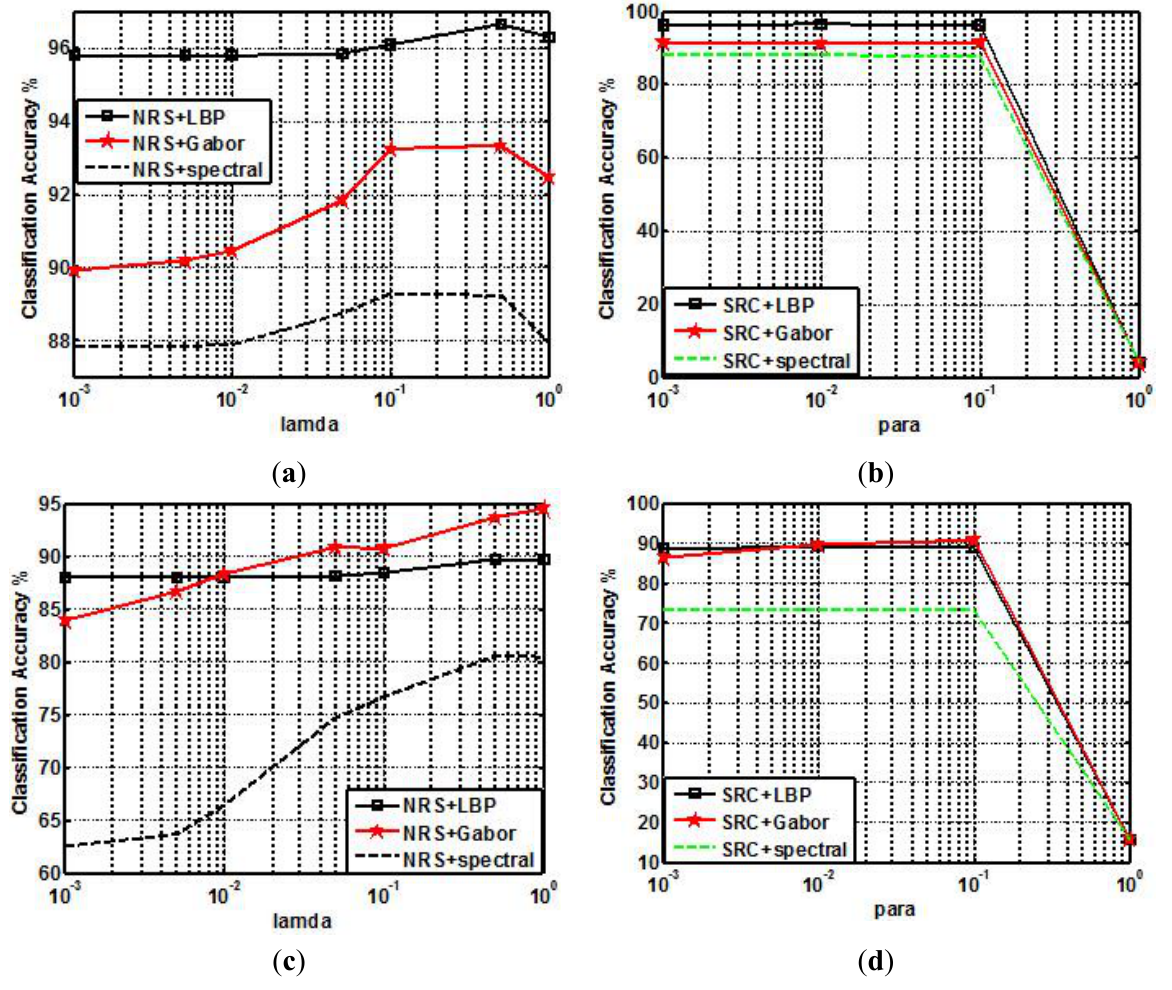
Figure 6. Classification accuracy (%) on two datasets using different parameters for  : ( a ) and ( b ) Salinas dataset with 30 training samples per class, and ( c ) and ( d ) University of Pavia dataset with 60 training samples per class. Table 3. Classification accuracy (%) versus the values of University of Pavia dataset with 60 training samples per